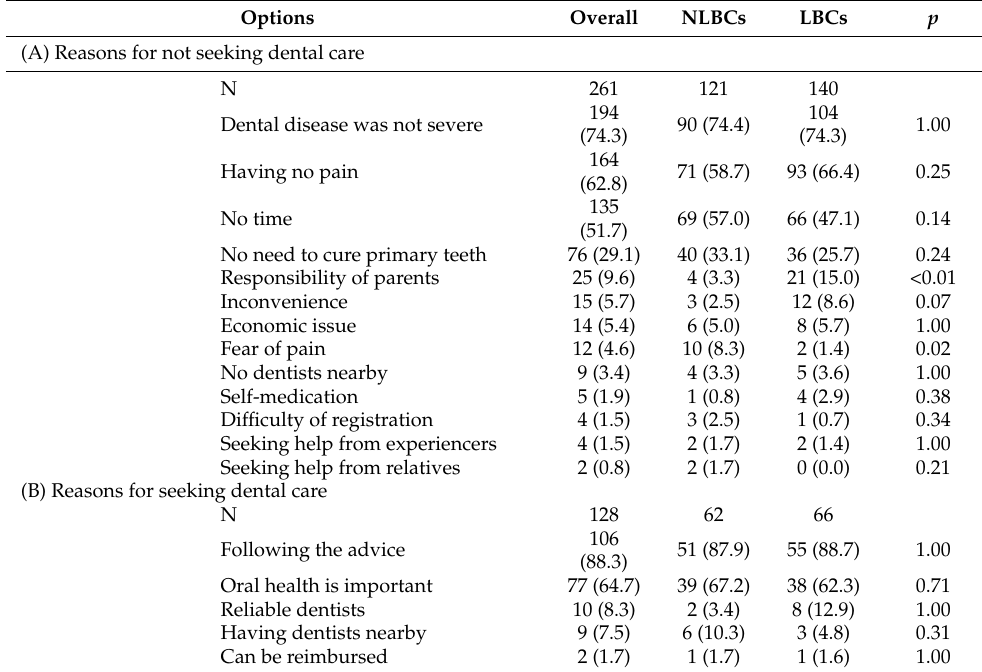
Table 2. Reasons of seeking or not dental care of caregivers of NLBCs and LBCs (multiple answers). Options Overall NLBCs LBCs